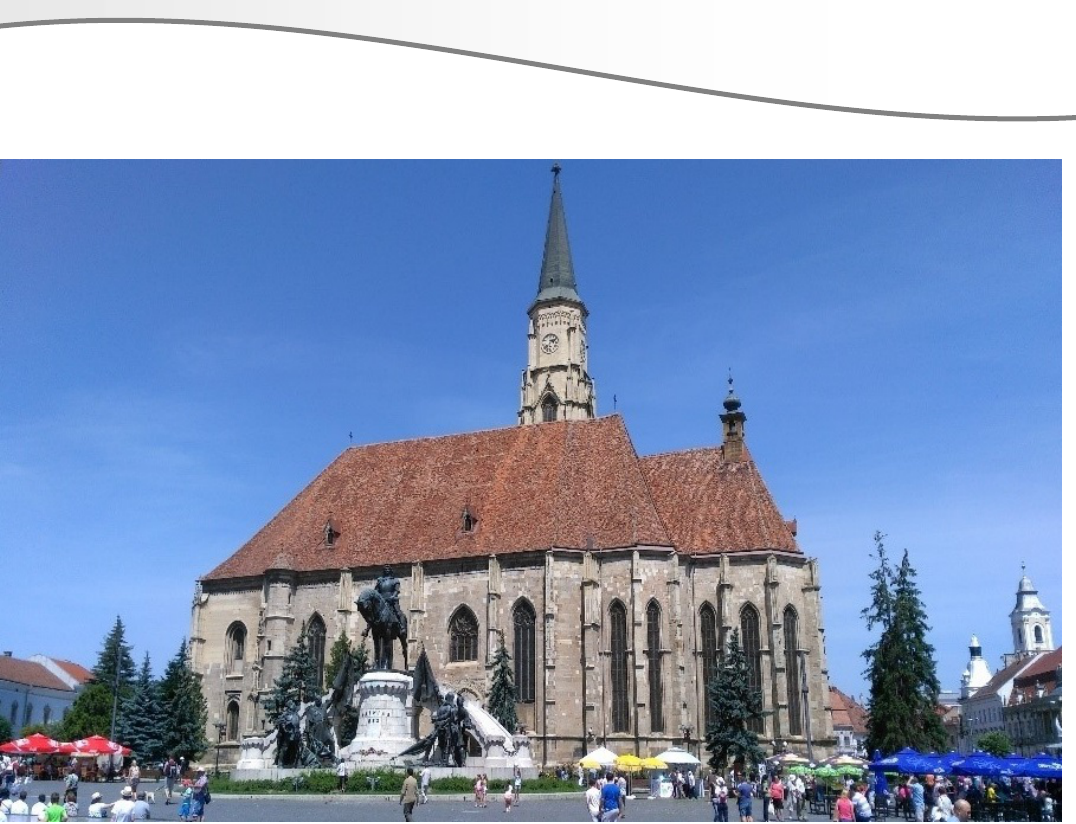
Figure 4: Landscape of Union Square: mirroring the history of Cluj-Napoca Source: Emanuel-Cristian ADOREAN, 2016© Table 1: Territorial balance of the squares from Cluj-Napoca city centre (Maroși et al., 2019) Green Total Pedestrian Road e r area h CENTRAL SQUARES Functions surface* surface surface t surface O m 2 m 2 % m 2 % m 2 % % Union